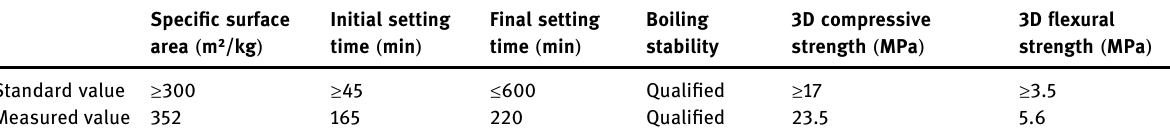
Table 2: Properties of cement